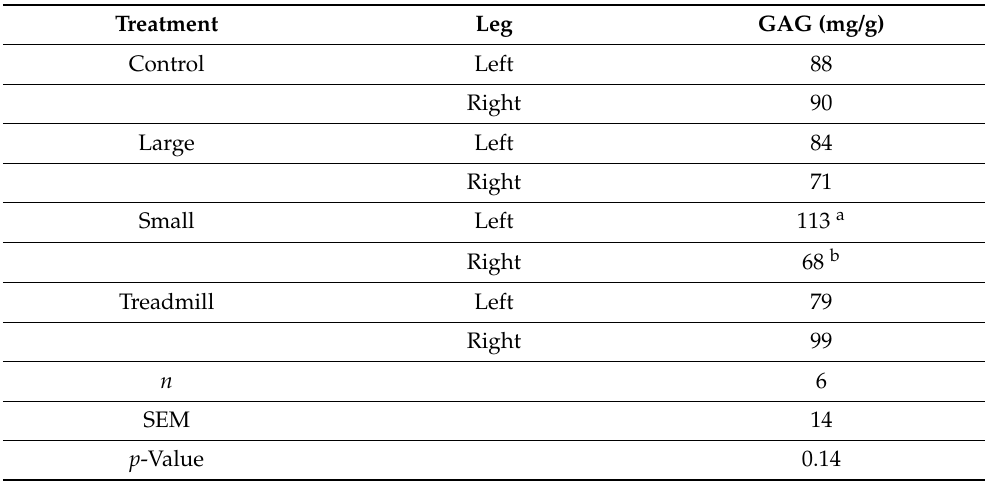
Table 8. Average glycosaminoglycan concentration in cartilage slices from the proximal surface of the MC III and IV by treatment and